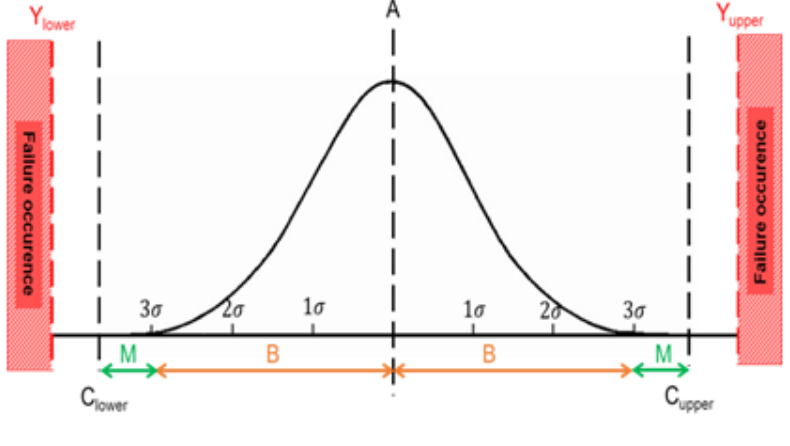
Figure 18. Detailed specification based on process